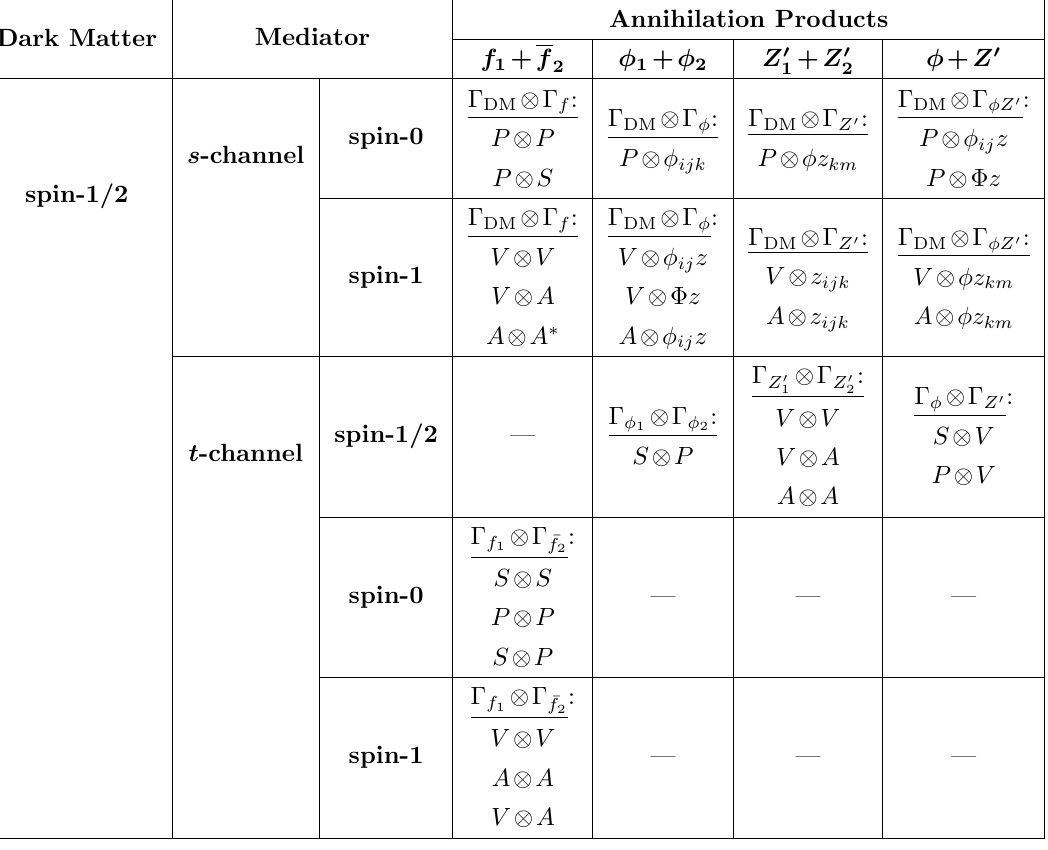
Table 1 . For each annihilation diagram, mediator spin, and choice of annihilation products, we identify the combinations of interactions that could enable a fermionic dark matter candidate to annihilate with an s -wave amplitude. We use the labels as indicated in eqs. (2.1){(2.3) to denote the types of interactions that lead to an s -wave annihilation amplitude. Those cases denoted with a ‘-’ do not correspond to any renormalizable model within our framework. Asterisks indicate cases in which the amplitude is s -wave but (if the dark matter is its own antiparticle) the cross section is helicity suppressed ( (cid:27)v m 2 =m 2 (cid:31) f /